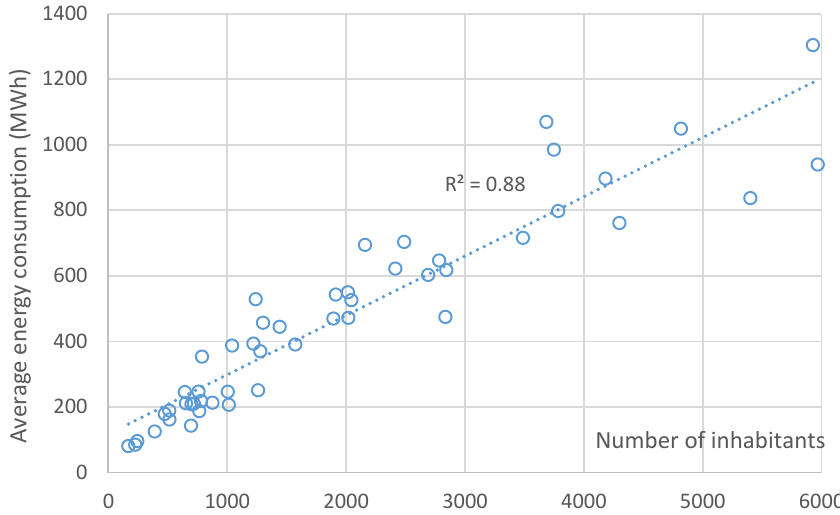
Figure 2. Relationship between the average annual final energy consumption of a municipality and its number of inhabitants.